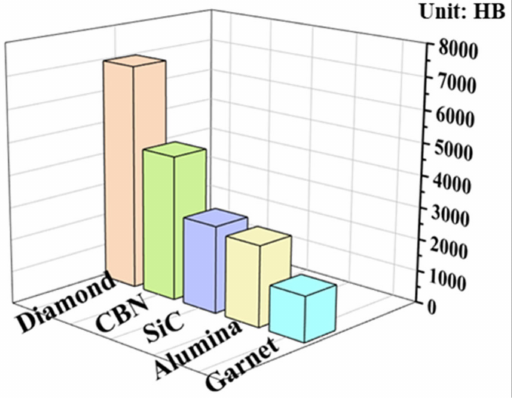
Figure 1. Comparison of hardness values of diamond and several common abrasive